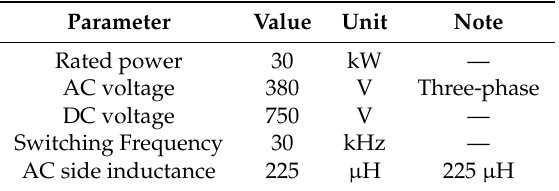
Table 3. Rated parameters of the PWM rectifier.